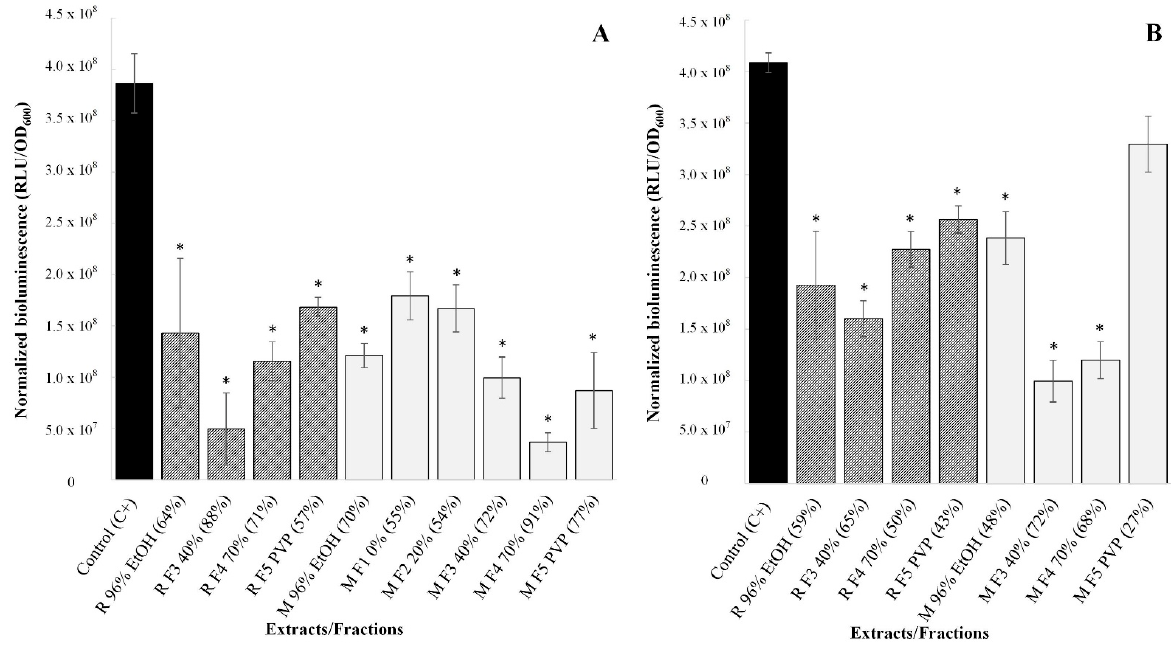
Figure 2. Bioluminescence reported after the addition of V. harveyi MM30 to 5% of SM obtained from non-treated control (C+) or to 5% of SMs obtained after treating C. jejuni NCTC 11168 with different preparations in sub-inhibitory concentrations (( A ): 0.25 × MIC; ( B ): 15.625 mg/L). Average bioluminescence in RLU with deducted background and normalized to OD 600 are presented ± standard deviations. In addition, the bioluminescence reduction rate is presented in brackets. * represents statistically significant